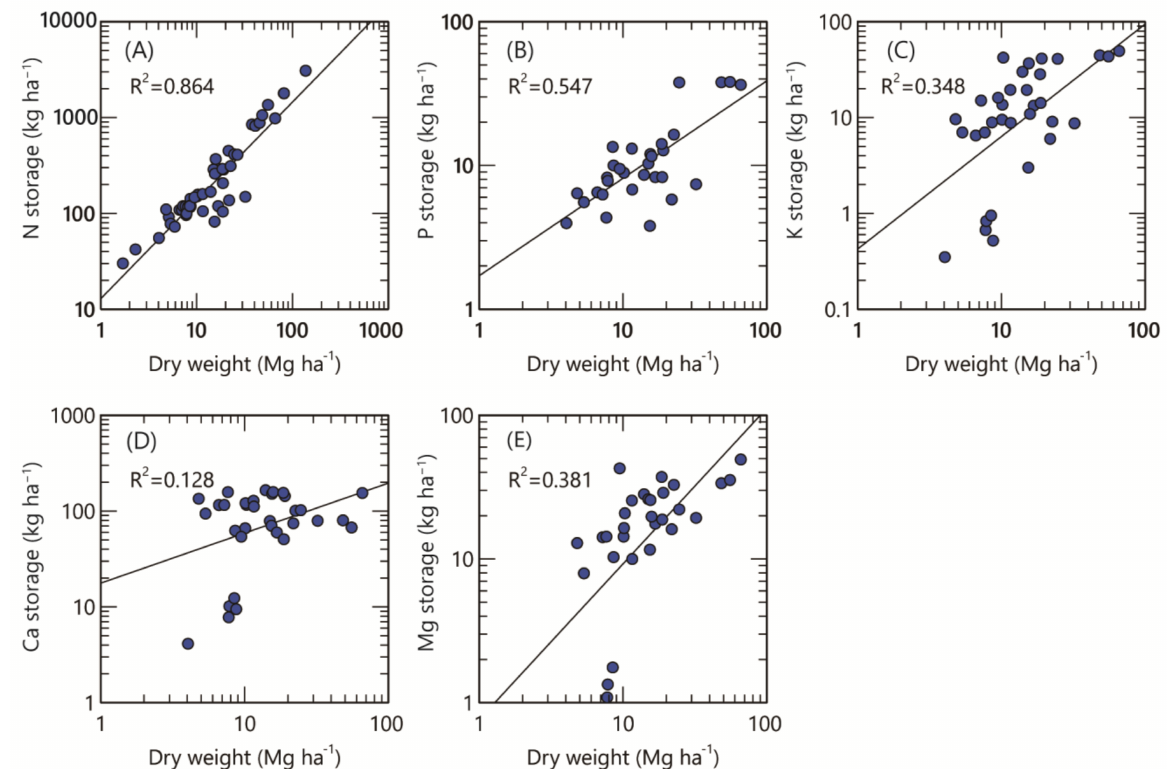
Figure 6. Relationship between nutrient storage (nitrogen ( A ), phosphorus ( B ), potassium ( C ), calcium ( D ), and magnesium ( E )) and dry weight of the forest floor in deciduous broad-leaved forests in Japan. Regression equations are shown in Table